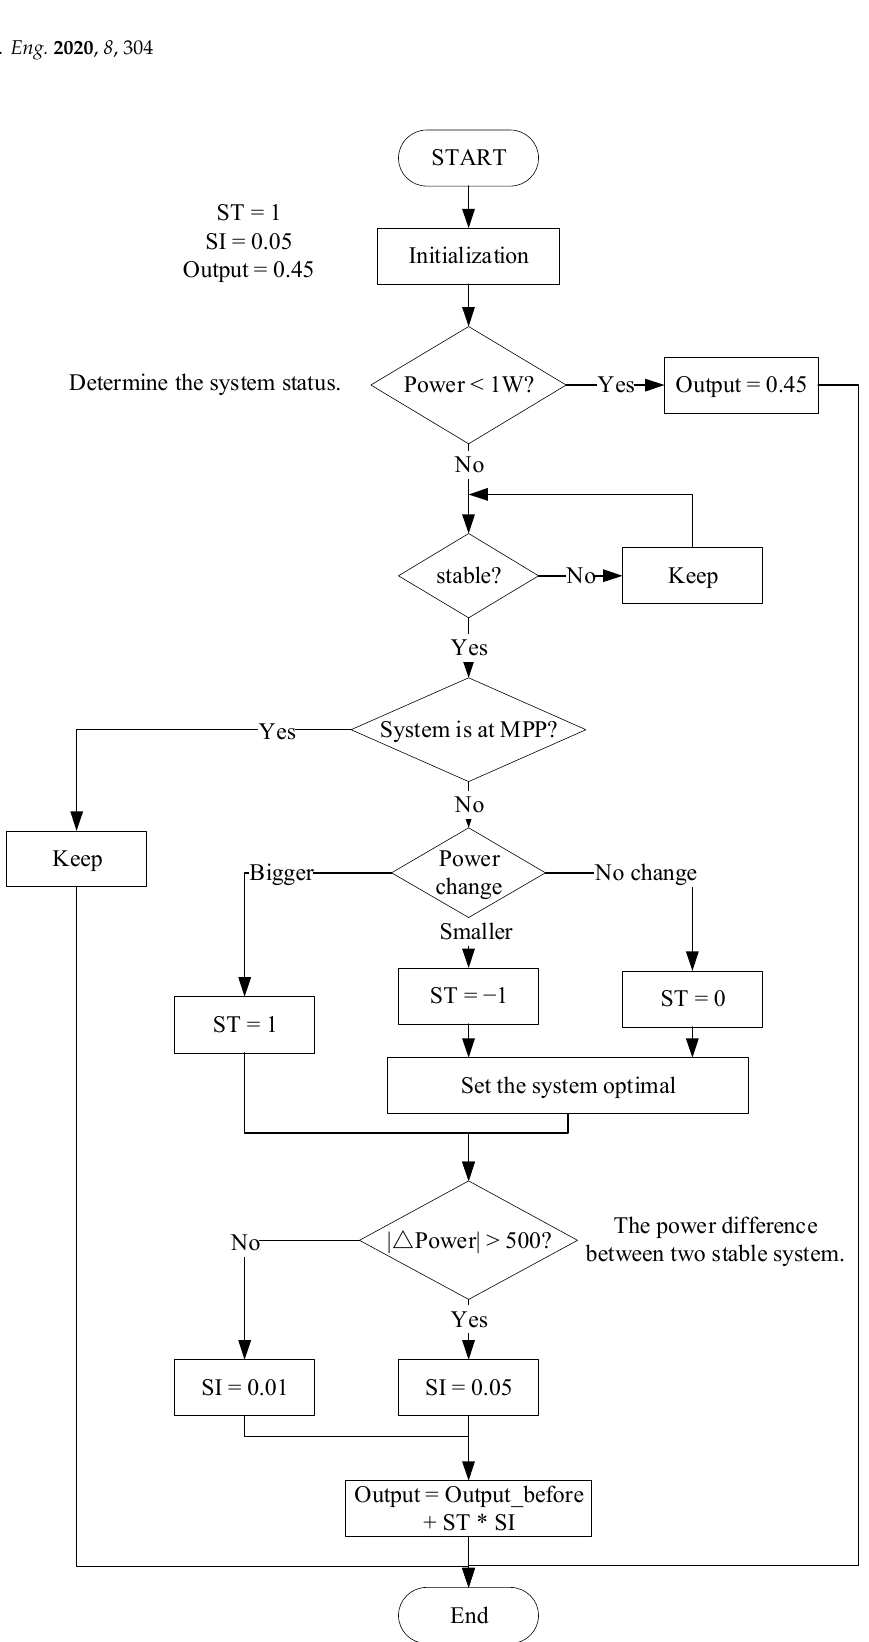
Figure 9. The control flow of the MPPT algorithm.